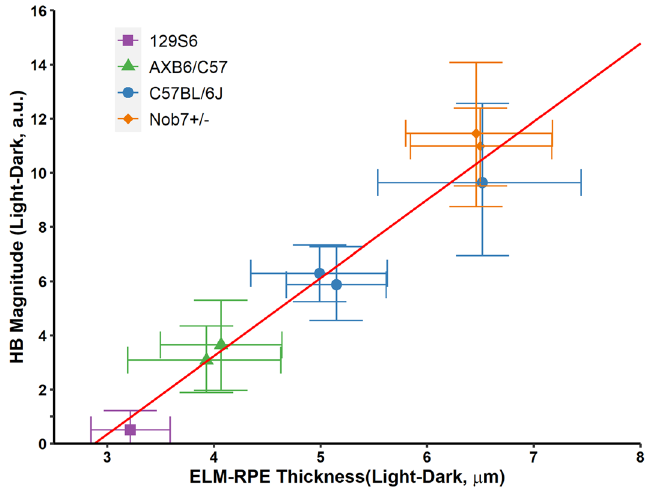
Figure 4. Correlation of light–dark HB magnitude with ELM-RPE thickness changes. Responses were obtained from 8 mouse groups (Table 1). The red line represents the significant association estimated by the Bayesian hierarchical model (the between-group correlation converted to a regression coefficient). All error bars represent 95% credibility